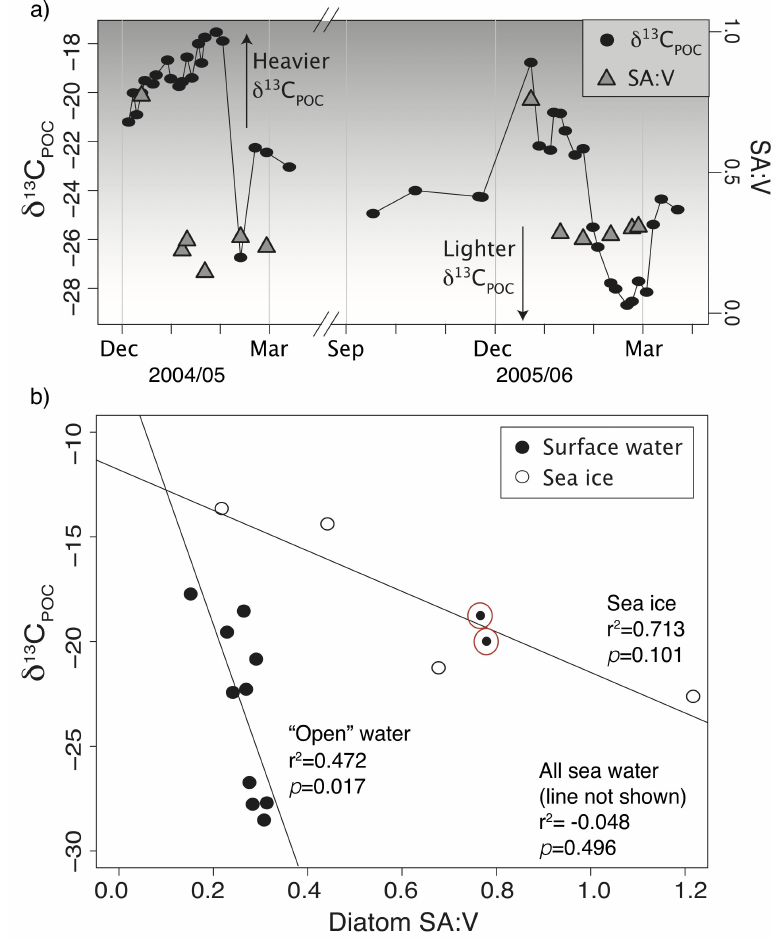
Fig. 9. Comparison of surface water diatom assemblage SA:V ratio (triangles) with δ 13 C POC (circles) in time-series data (a) and regression analysis (b) . Sea ice data are denoted in (b) by open symbols and sea water samples by filled symbols. The two water samples circled in (b) are early season samples postulated to be influenced by sea ice material and are not included in the “open” water regression line shown (see